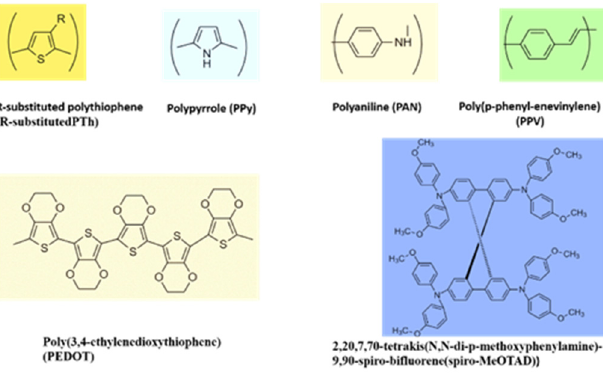
Figure 4. Chemical structures of a few conducting polymers with hole transport